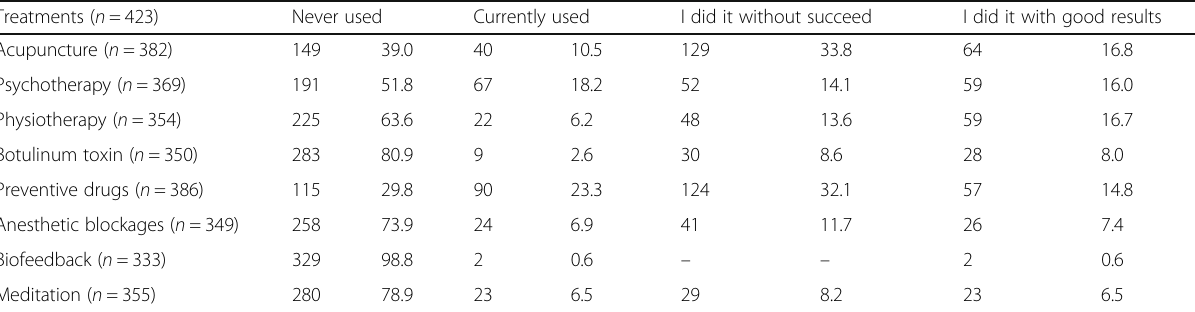
Table 4 Patients ’ experience with non-pharmacological treatments